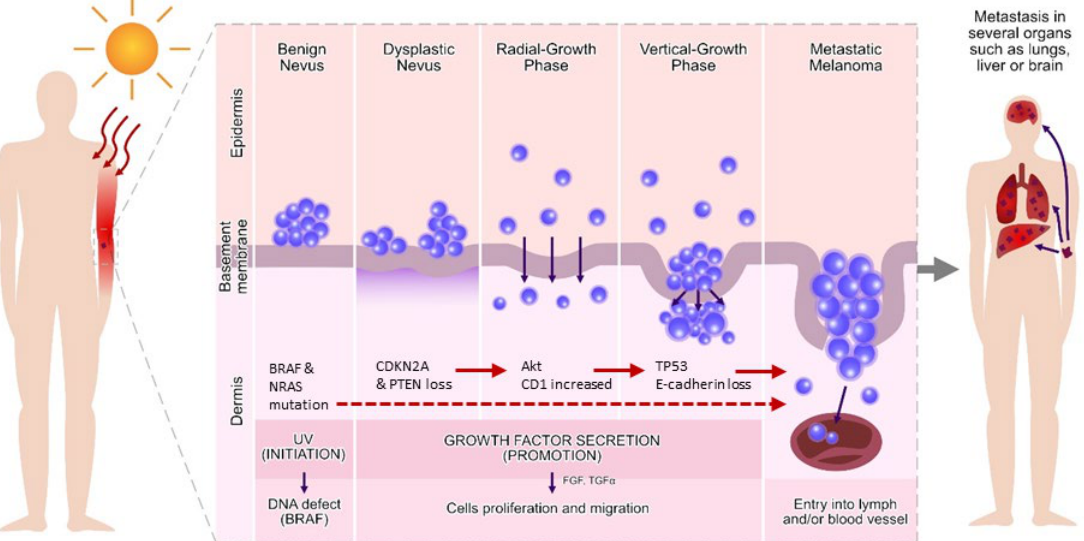
Figure 1. Process of metastasis in melanoma skin cancer and changes at the molecular level from initiation to progression of melanoma. This illustration depicts melanoma progression and molecular alterations that can occur at different stages, from benign nevus to metastatic melanoma. BRAF and N-RAS are commonly mutated in melanoma, as week as the heritable mutation (CDKN2A), but germline mutations (PTEN and TP53) develop melanoma rarely. Spontaneous DNA mutations in several genes involved in the progression of melanoma are encountered at different stages of the